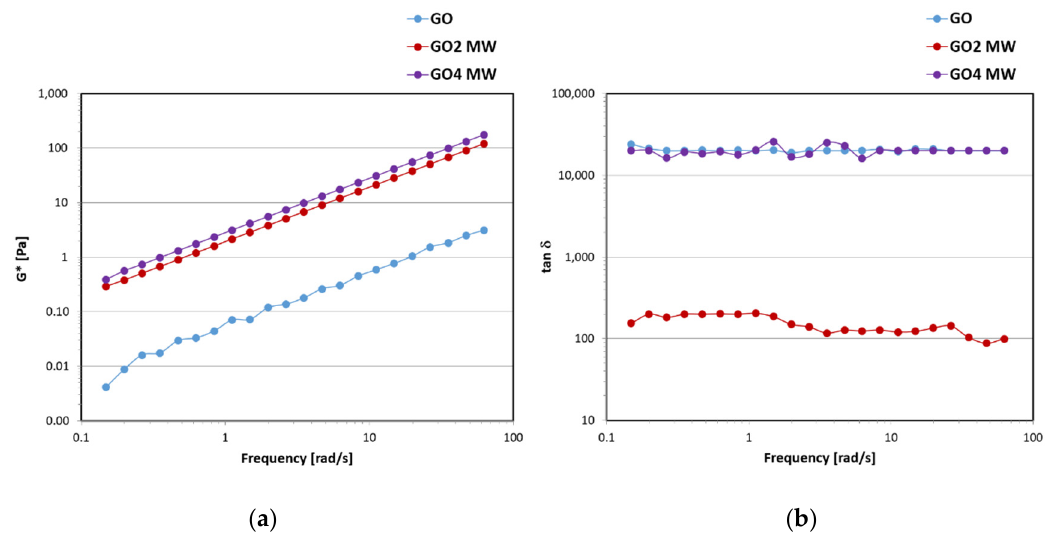
Figure 8. Trend of the complex G* modulus ( a ) and damping factor tan δ ( b ) in function of the oscillation frequency for GO, GO2 MW, and GO4 MW.